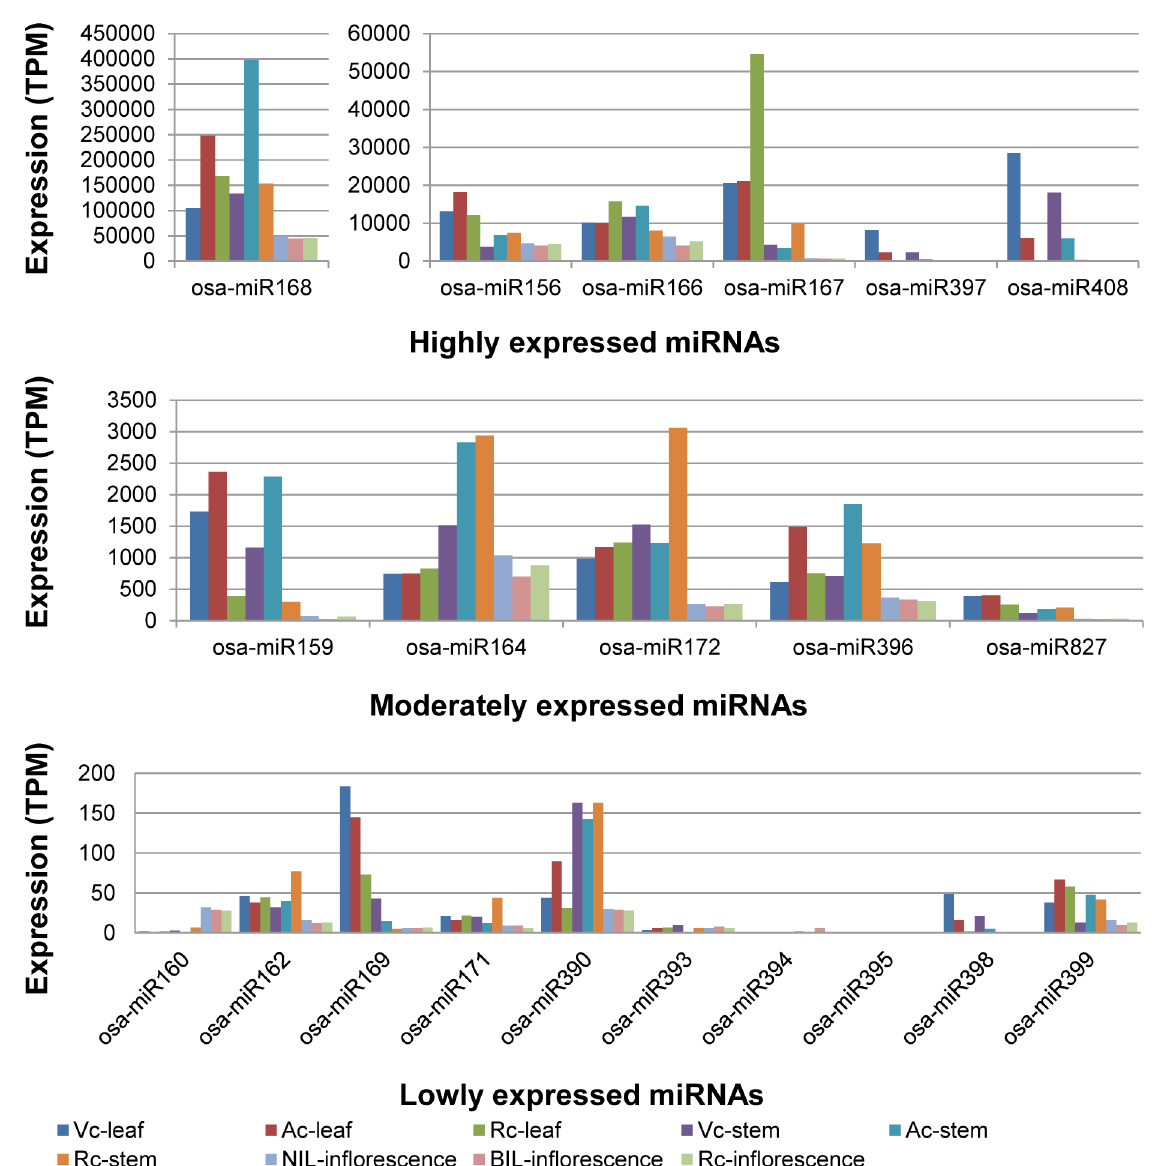
Fig 2. The expression levels of conserved miRNAs in different tissues of studied rice lines under control condition. V = Vandana,A = Aday Sel and R = IR64, NIL = IR87705-7-15-B, BIL = IR77298-14-1-2-10 rice lines whilec = control condition. Note: osa-miR167is moderatelyexpressedwhile osa-miR159, osa-miR397,osa-miR408 and osa-miR827are lowly expressedin rice inflorescence. However, due to their higherexpressionin vegetativetissues, they are shown in the higherexpressionbar graphs for clearer visualization. osa-miR395is non-detectable in rice inflorescence.